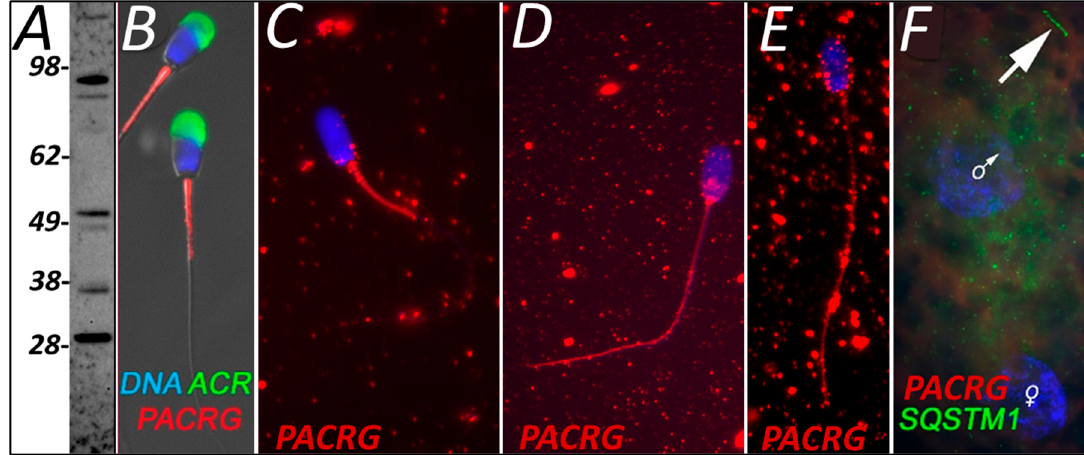
Figure 3. PACRG was identified in ejaculated sperm utilizing Western blot detection ( A ) and immunocytochemistry before fertilization ( B ). Predicted mass for various PACRG isoforms ranges from 26.5 to 33 kDa, while polymorphisms and stable, covalent complexes with chaperones and other proteins are known, including covalent modification by multi-ubiquitin chains. Within the cell-free system, primed and buffer exposed spermatozoa saw no difference in localization when compared to ejaculated sperm ( C ); however, after 4 h of cell-free treatment PACRG underwent a dramatic change in localization ( D ). After 24 h of cell-free system exposure, a similar localization signature was observed ( E ). PACRG was no longer detectable in a one-cell zygote ( F